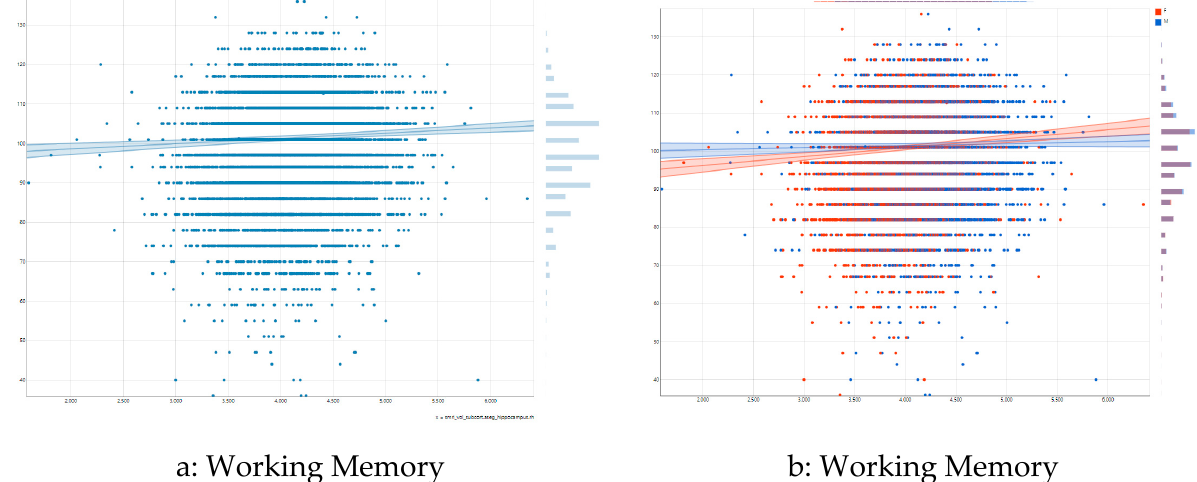
Figure 2. Association between right hippocampal volume and list sorting working memory by sex. ( a ) overall association; ( b ) association by sex.